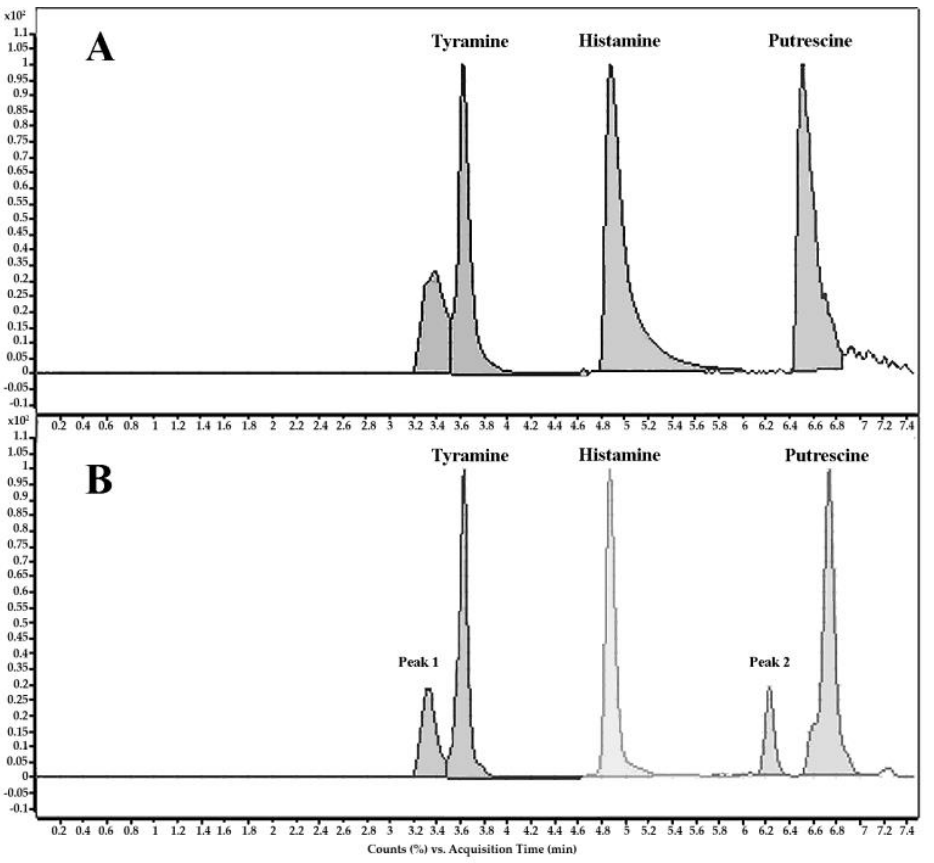
Figure 3. Chromatogram obtained for the analysis of biogenic amines by using UHPLC-MS / MS for: ( A ) mixture of histamine, tyramine, and putrescine standard solution and ( B ) UVI-18 wine sample.